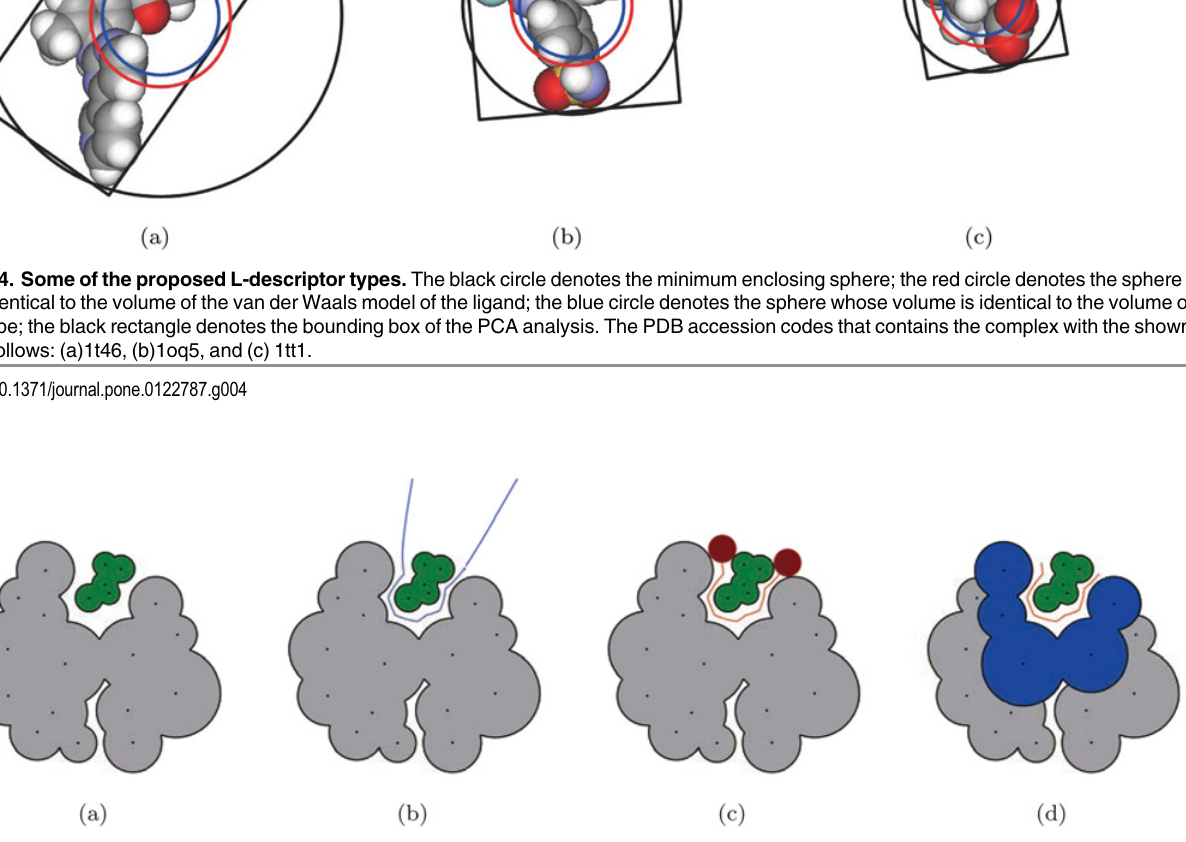
PLOS ONE | DOI:10.1371/journal.pone.0122787 April 2,